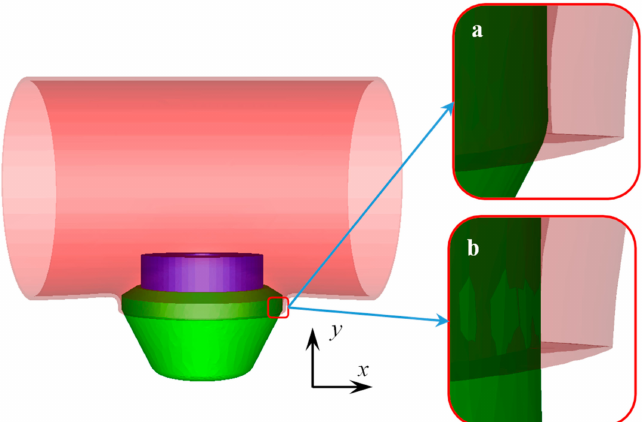
Figure 23. Contact of the end of the branch at the third and the fourth flanging stages, strokes of upper die were ( a ) 430 mm, ( b ) 450